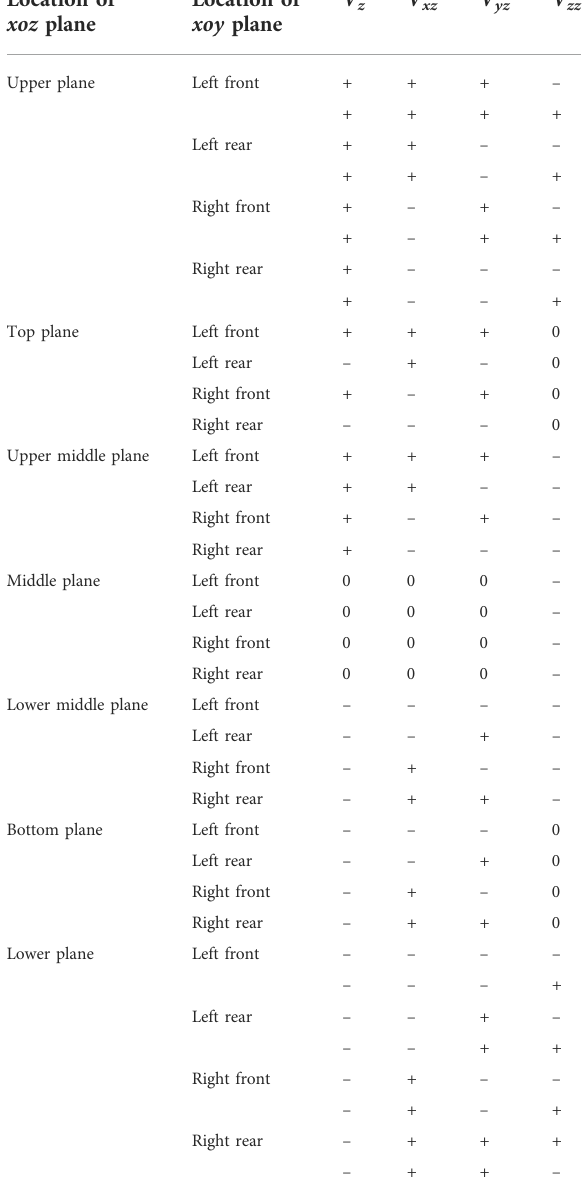
TABLE 1 Correspondence between plane positions and the four parameters of vertical high-density cuboid orebodies. Location of xoz